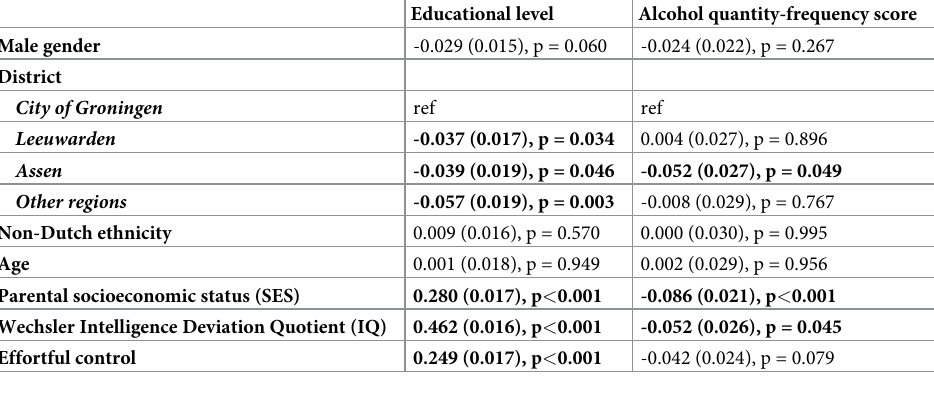
Table 3. The association between baseline characteristics (wave 1) and educational level and alcohol use at wave 2 in the TRAILS Study (the Netherlands, 2000–2017, N = 2,229) in the multivariate-adjusted cross-lagged panel model (model 2) in Fig 2; linear regression coefficients (stdyx-standardized ß-coefficient, robust standard error, p-value); all predictors are mutually